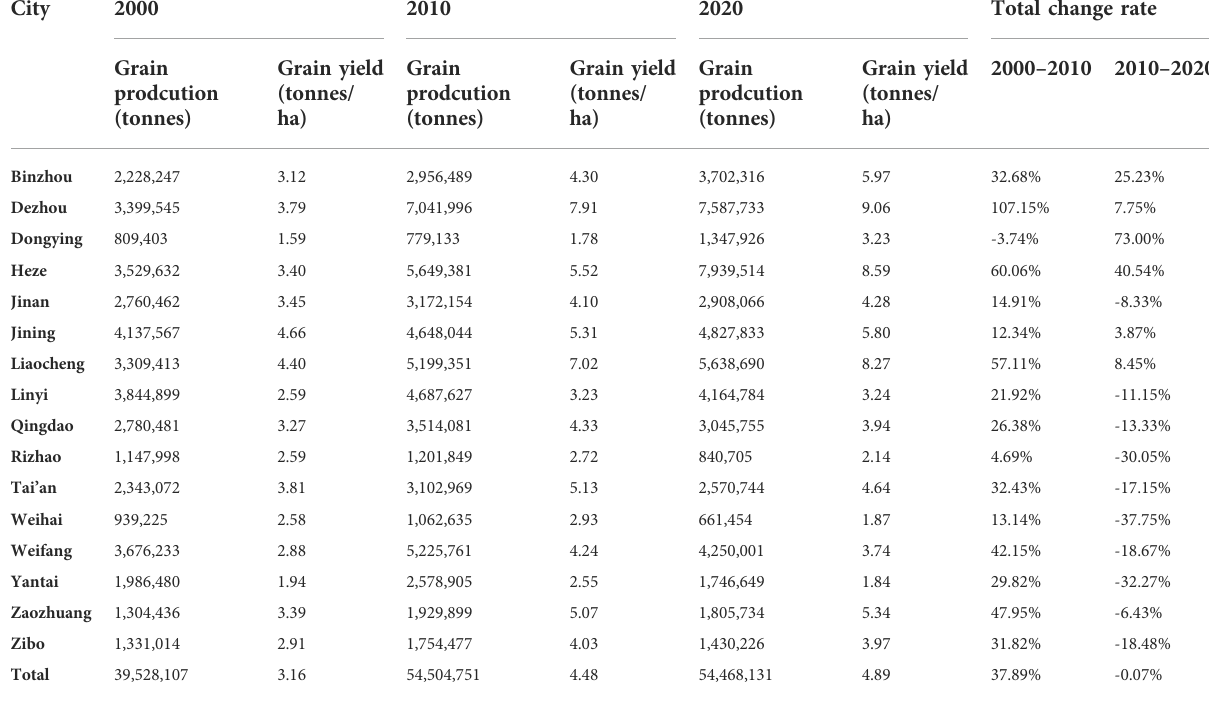
TABLE 3 Grain production and grain yield during 2000 – 2020